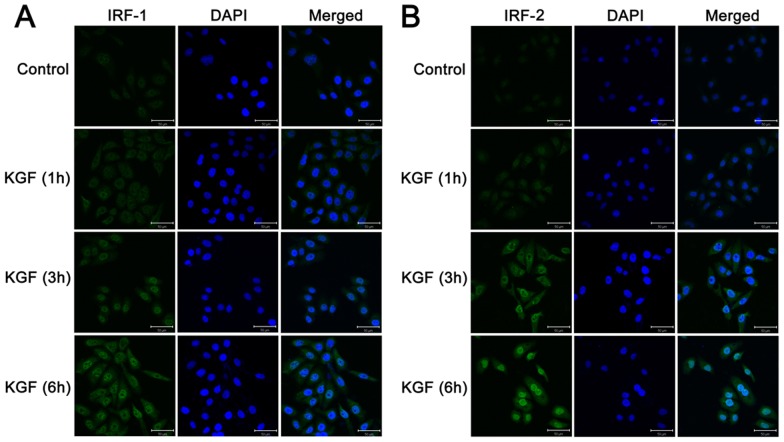
Increased expression of IRF-1 and IRF-2 were confirmed by immunofluorenscence staining with KGF treatment in vitro.Increased expression of IRF-1 and IRF-2 in the nucleus were observed after 6 h with KGF treatment.